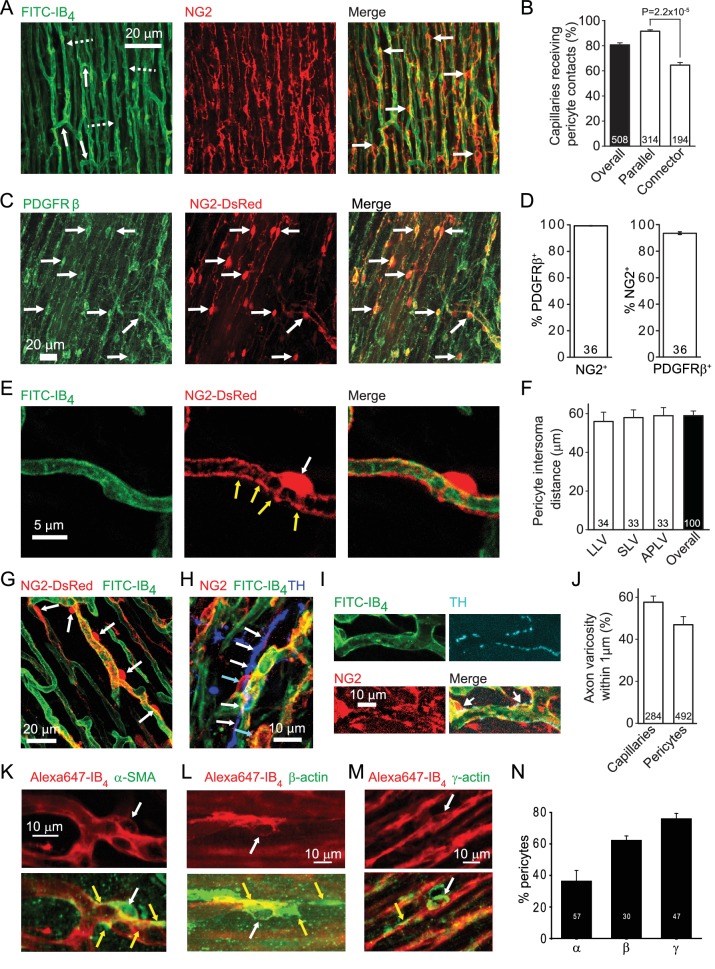
Cardiac pericyte morphology is appropriate for regulating capillary diameter.(A) Coronary capillaries in rat left ventricle (dashed arrows in left panel show longitudinal capillaries, solid arrows show connector capillaries) labelled for basement membrane (FITC-isolectin B4) and for pericytes (example somata labelled with arrows in right panel) with antibody to the proteoglycan NG2. (B) A larger percentage of parallel capillaries (in rat,) receive pericyte contacts (<1 μm away) than do connector capillaries running between the parallel capillaries. (C) Mouse pericytes labelled with antibody to PDGFRβ (example somata labelled with arrows) and with NG2-DsRed. (D) Percentage of 2874 NG2-expressing pericytes (left) that also express PDGFRβ and of 3047 PDGFRβ−expressing pericytes (right) that also expressed NG2 (averaged over 36 confocal stacks each, from 4 mice, 2–9 months old) in the left ventricle of NG2-dsRed mice. (E) Pericyte in NG2-DsRed mouse showing soma (white arrow) and circumferential and longitudinal processes (yellow arrows). (F) The mean rat pericyte inter-soma distance is similar in the lateral wall of the left ventricle (LLV), the septal wall of the left ventricle (SLV), and anterior and posterior walls of the left ventricle (APLV). (G) Mouse pericyte circumferential processes can extend over much of the capillary surface between pericyte somata. (H) Labelling of tyrosine hydroxylase (blue) shows a close association of sympathetic axons (white arrows) with rat pericytes (cyan arrows). (I) At higher magnification, tyrosine hydroxylase labelled axon varicosities (putative transmitter release sites, cyan) can be seen apposed to pericyte somata and processes. (J) Both capillaries and pericytes (including soma and processes) frequently have sympathetic axon varicosities within 1 μm (in rat). (K–M) Examples of pericytes labelled with Alexa647-isolectin B4 (red) that also labelled (green) for α-SMA (K), β-actin (L) or γ1-actin (M). White arrows indicate somata; yellow arrows indicate actin-labelled processes. (N) Percentage of pericytes expressing the 3 actin isoforms in three hearts. Data are mean ± s.e.m. Numbers on bars are of capillaries (panels B, J), images (D), intersoma distances (F) or pericytes (J, N).